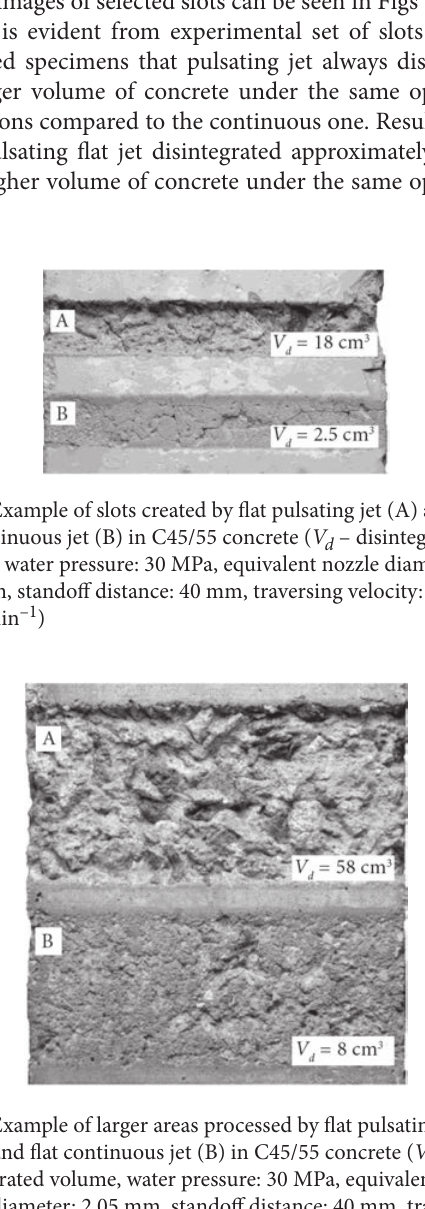
Fig. 8. Cross-section of slots created by rotating continuous jets (A) and rotating pulsating jets (B) in C45/55 concrete